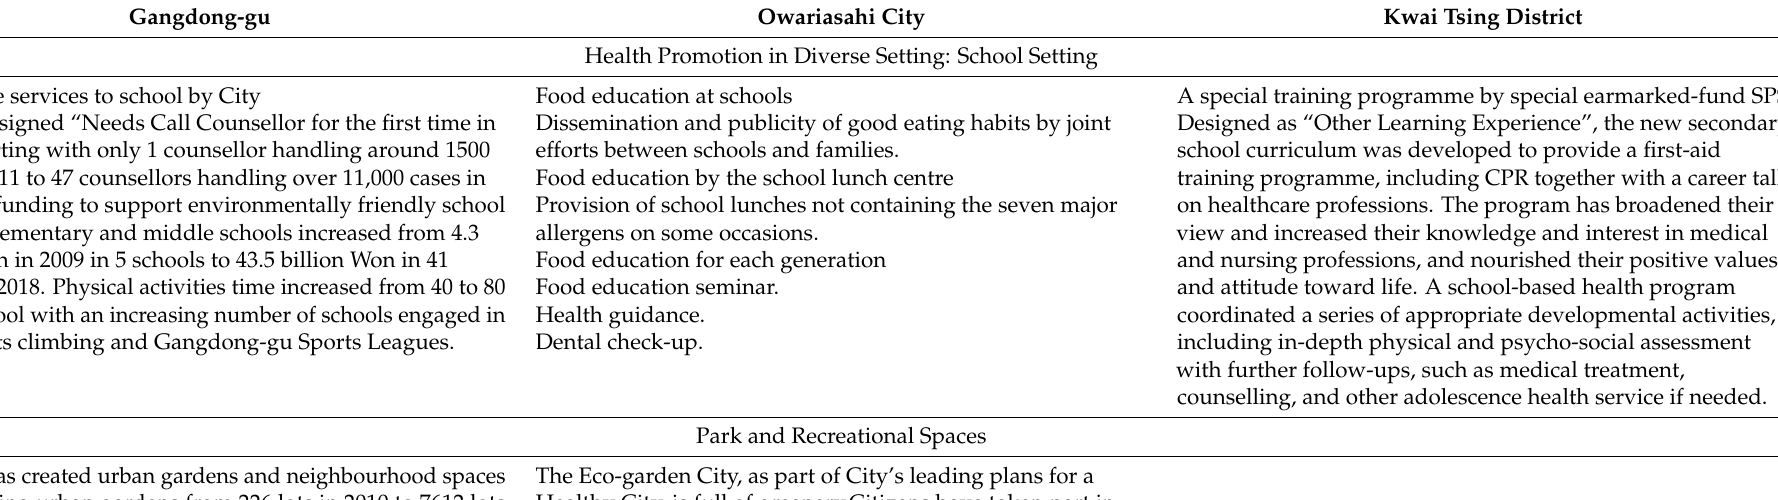
Table 2. Health promotion in diverse settings and strategic plans to enhance